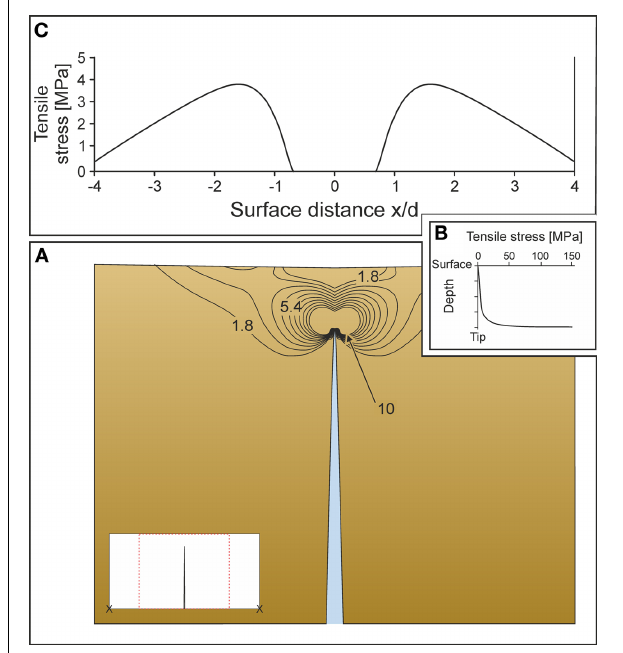
FIGURE 11 | Boundary-element model of the tensile stress around a hydrofracture in a homogeneous isotropic crust with Young’s modulus 100GPa, Poisson’s ratio 0.25. The inset in (A) shows the set-up of the model: the model is 3 units high and 6 units wide. The dashed lines indicate the part of the model which is shown on the large results figure. The crosses indicate the boundary conditions of no displacement in the lower corners of the model. The hydrofracture tip is at 0.5 units below the surface. (A) Concentration of the maximum principal tensile stress (minimum compressive stress) σ 3 , in mega-pascals (truncated at 1 and 10MPa). The aperture of the hydrofracture is shown 150 times exaggerated. In a large area around the fracture tip, tensile stresses exceed 10MPa. (B) Tensile stress distribution from the surface to the hydrofracture tip. The tensile stress is zero at the surface, but at the tip, it reaches 149MPa. (C) Maximum principal tensile stress at the surface. The tensile stress distribution has a peak of 4MPa on either side of the fracture tip at a horizontal distance 1.6 times the distance to the hydrofracture tip below the surface (“surface